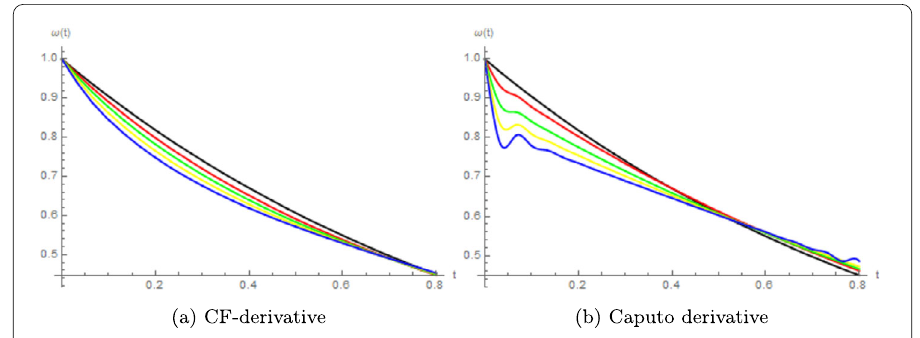
Figure 5 Fractional level curves of approximate solution of Example 5.3: blue α = 0.8, yellow α = 0.85, green α = 0.9, red α = 0.95, and black line α =